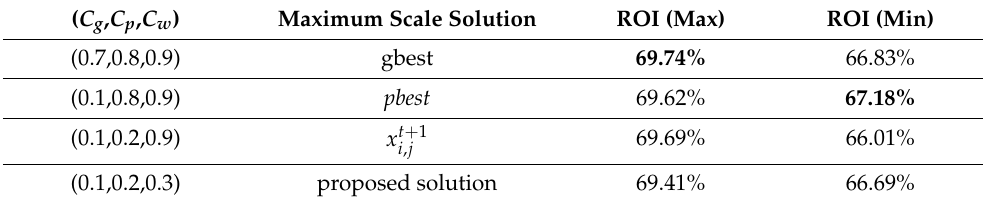
Table 6. Best and worst solutions under different parameter combinations (Experiment 1).